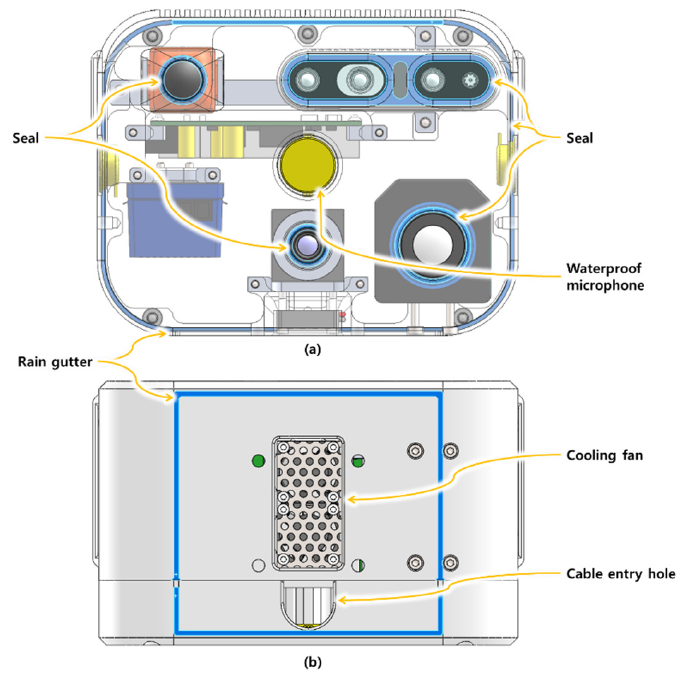
Figure 4. Arrangement of sensors. Measures to prevent rainwater inflow: ( a ) Front view (translucent); ( b ) bottom view.